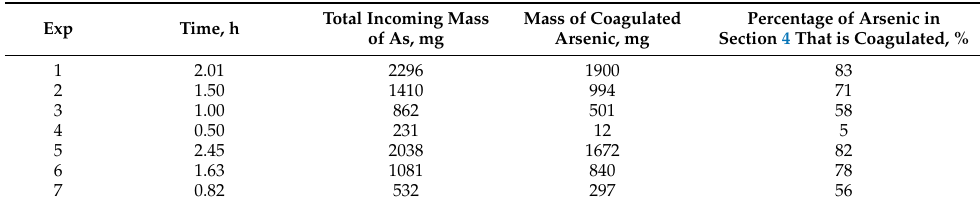
Table 2. Mass balance of arsenic in Section